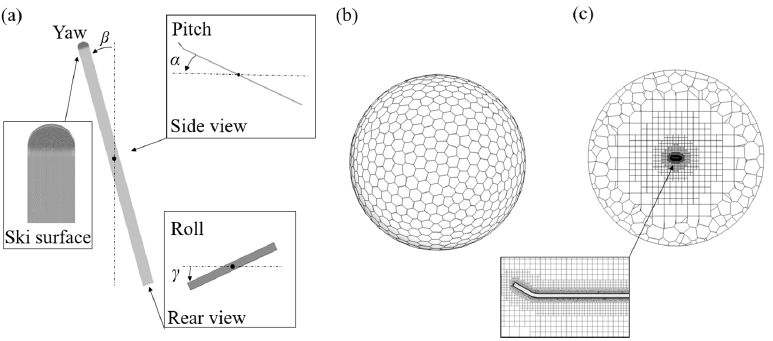
Figure 1. The ski attitude angles and computational mesh: ( a ) definition of attitude angles, ( b ) computational mesh of spherical fluid domain, and ( c ) mesh refinement around the